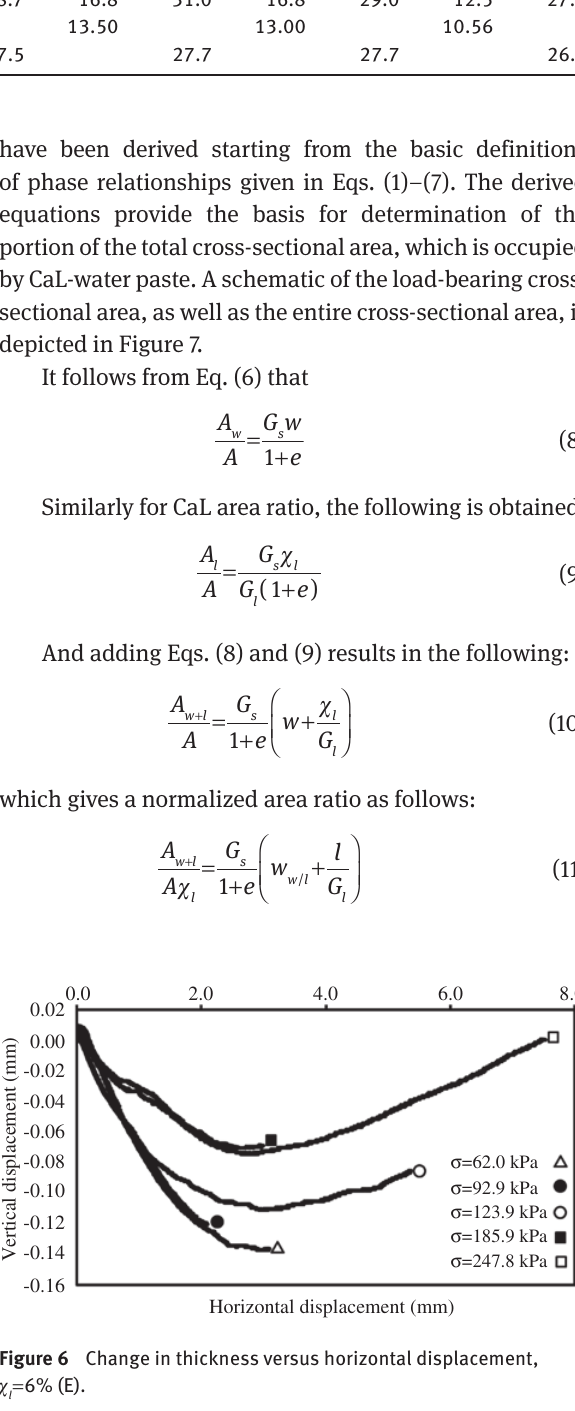
Figure 5 Shear stress versus horizontal displacement for χ